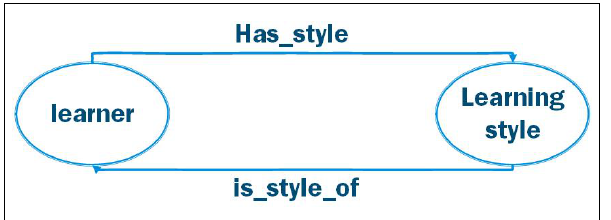
Figure 3. Concepts of LDO